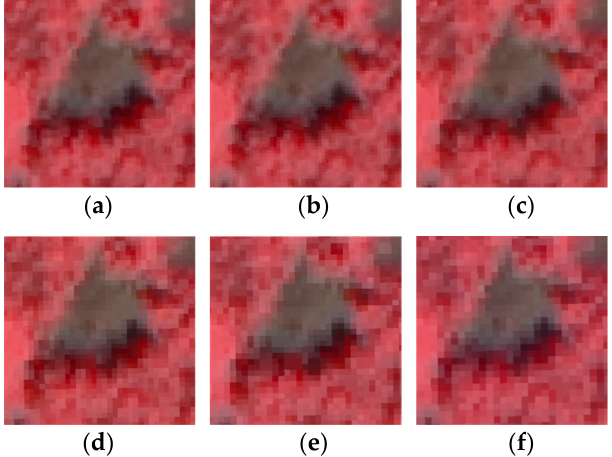
Figure 14. Verification remote sensing images at various resolutions: ( a ) 1.5 m, ( b ) 2.0 m, ( c ) 2.5 m, ( d ) 3.0 m, ( e ) 3.5 m, and ( f ) 4.0 m.